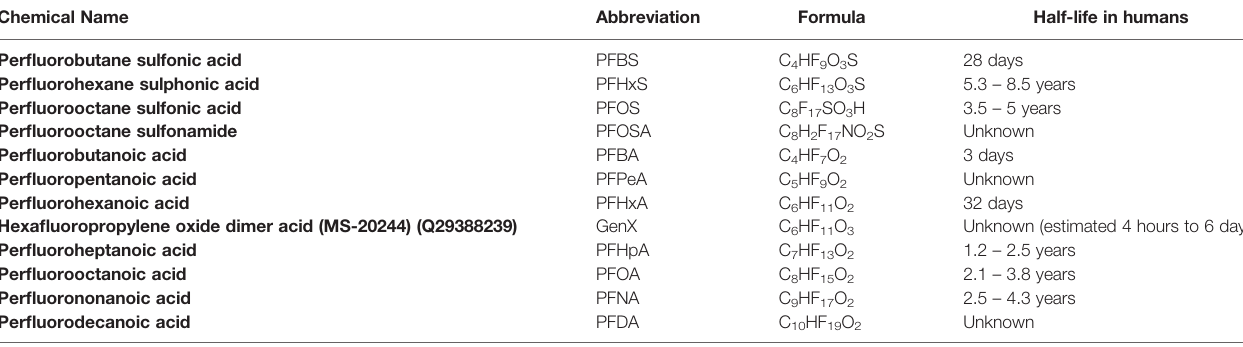
Table adapted from Fenton et al.